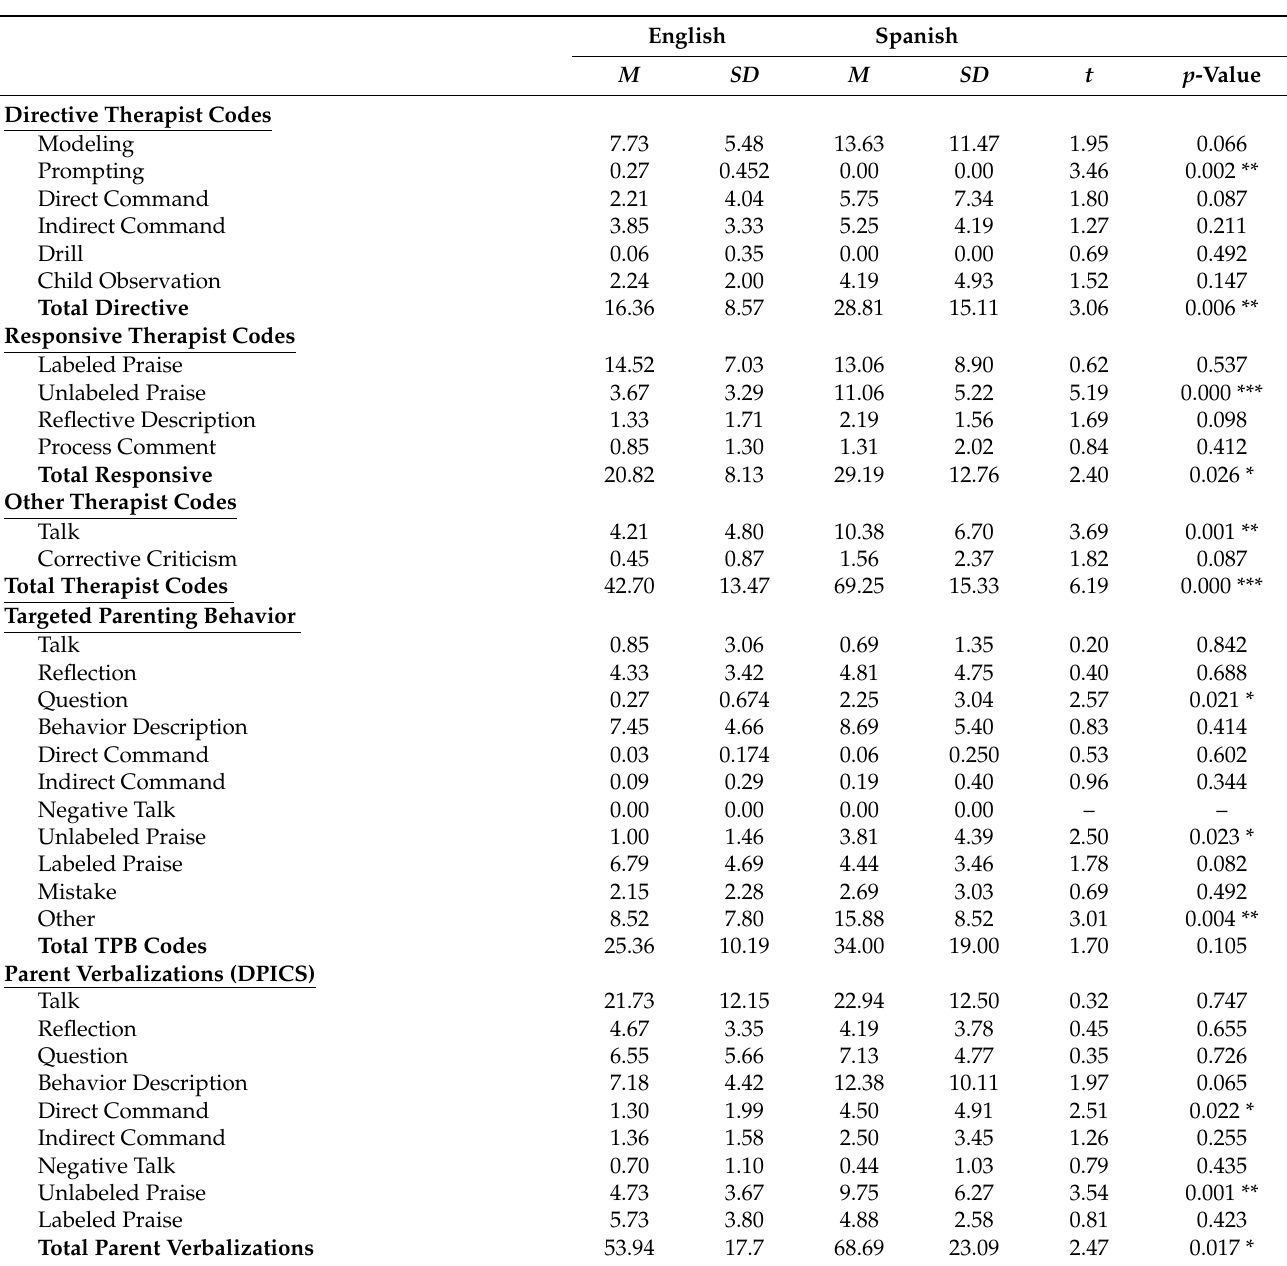
Table 1. Therapist and Parent